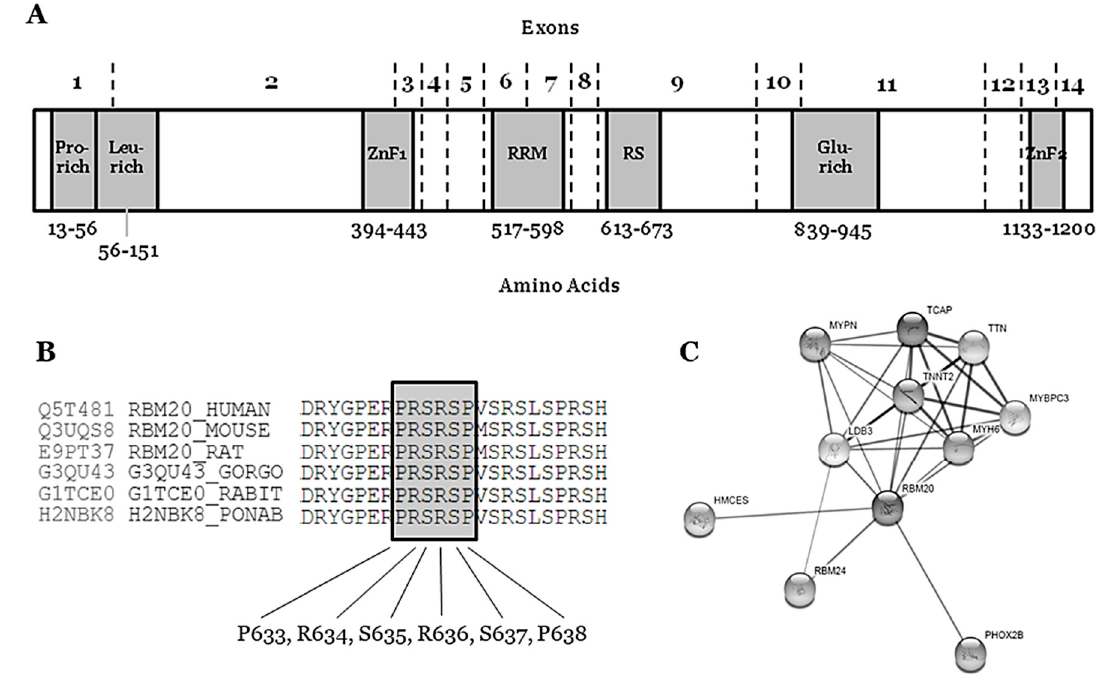
Figure 1. Structure and network of the RBM20 protein. ( A ) Glu-rich: Glutamate rich region; Leu-rich: Leucine rich region; Pro-rich: Proline rich region; RRM: RNA Recognition Motif; RS: Arginine-Serine Domain; ZnF1: Zinc Finger region 1; ZnF2: Zinc Finger region 2. ( B ) Conservation between species of RS region (amino acids 634–638). ( C ) Network of ten closest proteins to RBM20.